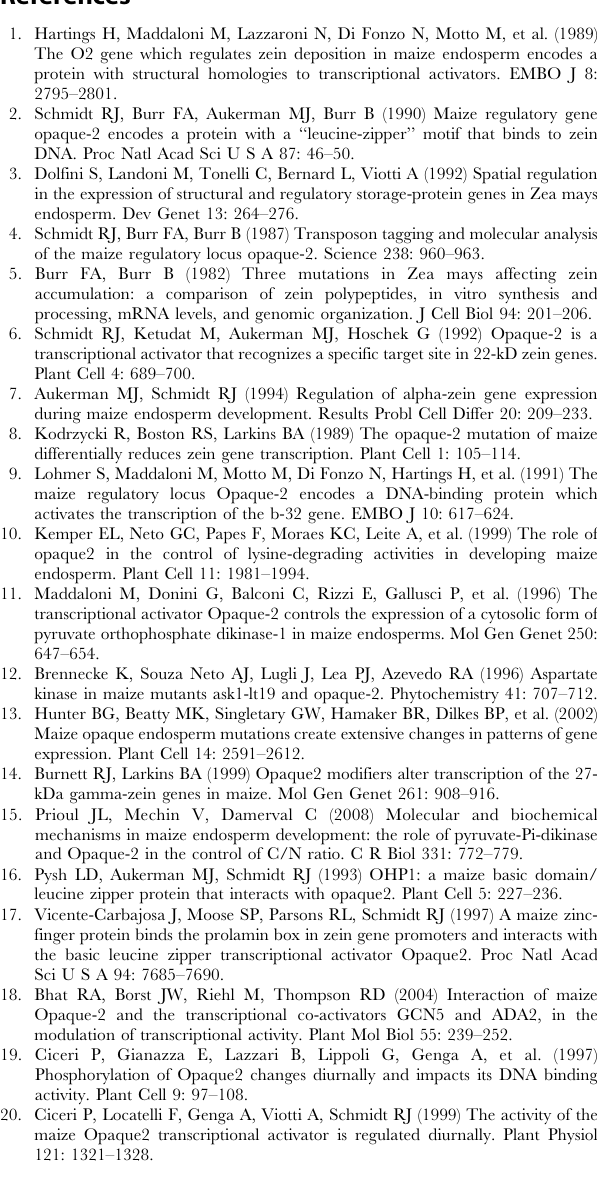
Figure S3 Localization of CFP-Taxilin in onion epider- mal cells. Onion epidermal cells were bombarded with CFP- Taxilin. Green represents CFP fluorescence. Differential interfer- ence contrast (DIC) was used in light mode. (PDF) Figure S4 Co-localization of CFP-Taxilin and YFP-O2 in onion epidermal cells. Red represents YFP fluorescence and green represents CFP fluorescence. Differential interference contrast (DIC) was used in light